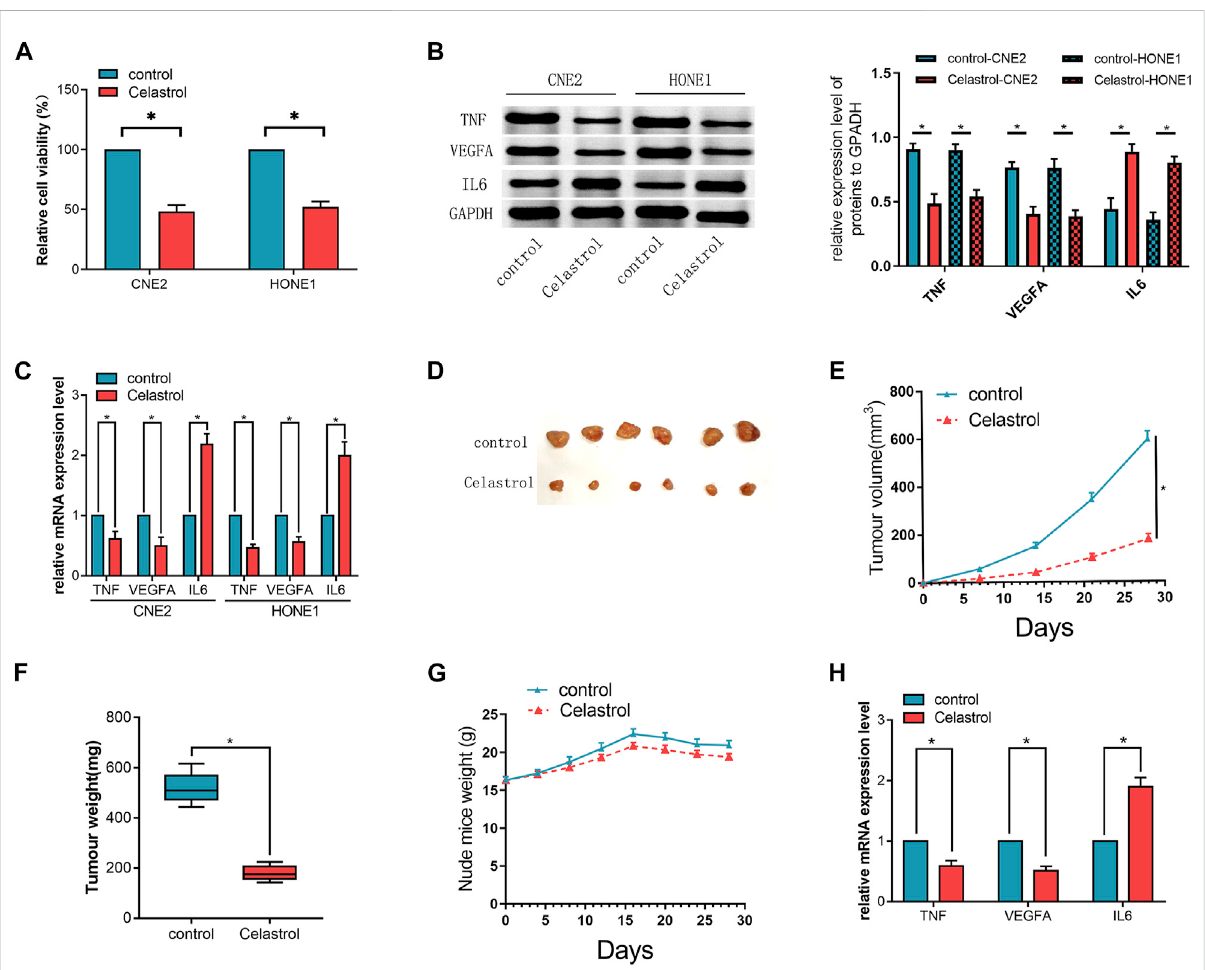
FIGURE 4 (A) The cell viability ofthecellsintheCelastrol-treatedgroup wassigni fi cantly lower thanthat ofthecellsinthecontrol group. (B,C) ThemRNA and protein expression levels of the candidate hub genes (TNF, VEGFA, and IL6) assessed by qRT-PCR (C) and western blot (B) , respectively, in CNE2andHONE1cells. (D) Theexcisedtransplantedtumorsintwogroupsofmousemodels. (E) Thevolumesofthetransplantedtumorsinthemice treated with or without Celastrol. (F) The weights of the tumors in the two groups. (G) The weight of the mice in the two groups. (H) The mRNA expressionlevelsofthecandidatehubgenes(TNF,VEGFA,andIL6)inthetransplantedtumorsassessedbyqRT-PCR.The t -testwasusedtocompare between the two groups. ( n = 3,* p < 0.05). The error bars represented the standard